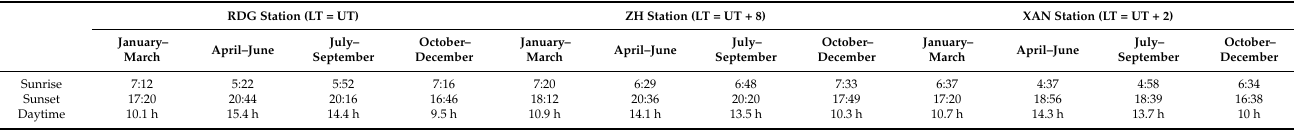
Table 2. Sunrise and sunset times in different seasons in 2021 for the three stations.